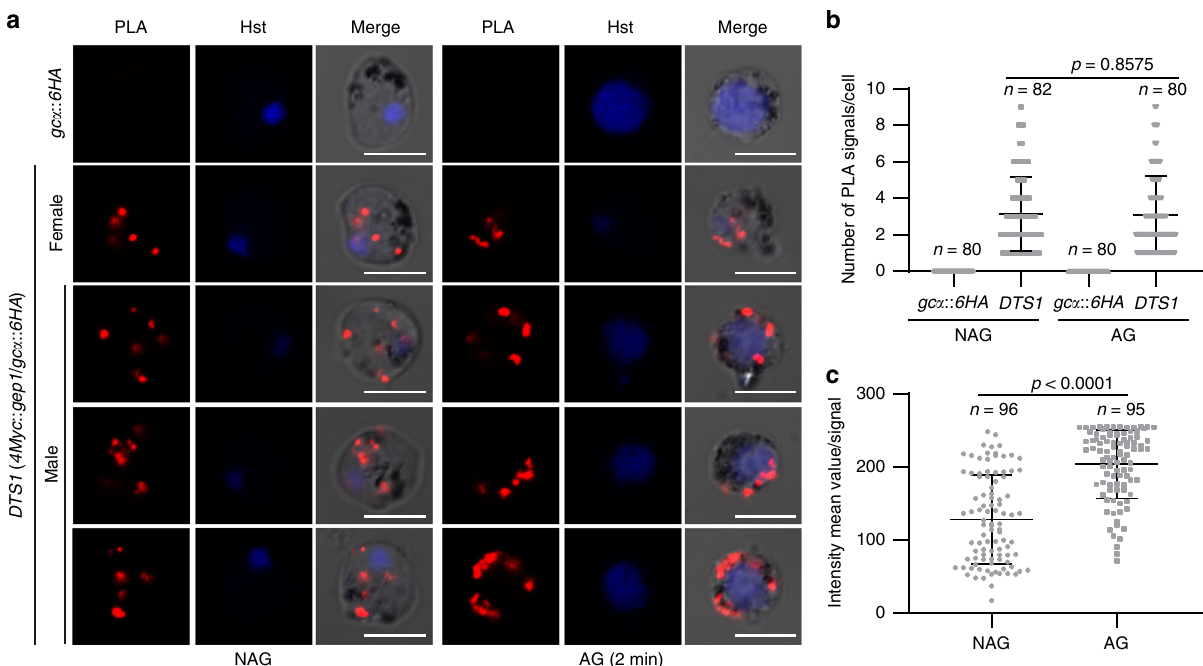
Fig. 8 XA stimulation likely enhances the interaction between GEP1 and GC α . a Proximity Ligation Assay (PLA) detecting protein interaction between GEP1 and GC α in DTS1 gametocytes. NAG: non-activated, AG: 2 min after XA stimulation. Activated male gametocytes were observed with enlarged nucleus containing replicated genome. Scale bar = 5 μ m. b Number of PLA signal dot in each cell shown in a , n is the number of cells counted. c Fluorescence intensity value for each PLA signal dot shown in a . n is the number of PLA signal dot measured. Source data are provided as a Source Data fi le. Experiment was repeated three times independently. Data are shown as mean ± SD; two-tailed unpaired Student ’ s t